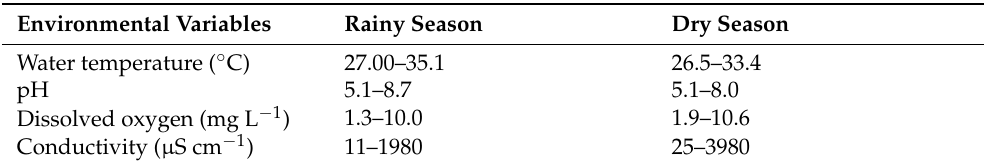
Table 2. Ranges of environmental variables measured from the sampled sites in southern Vietnam in the rainy and dry